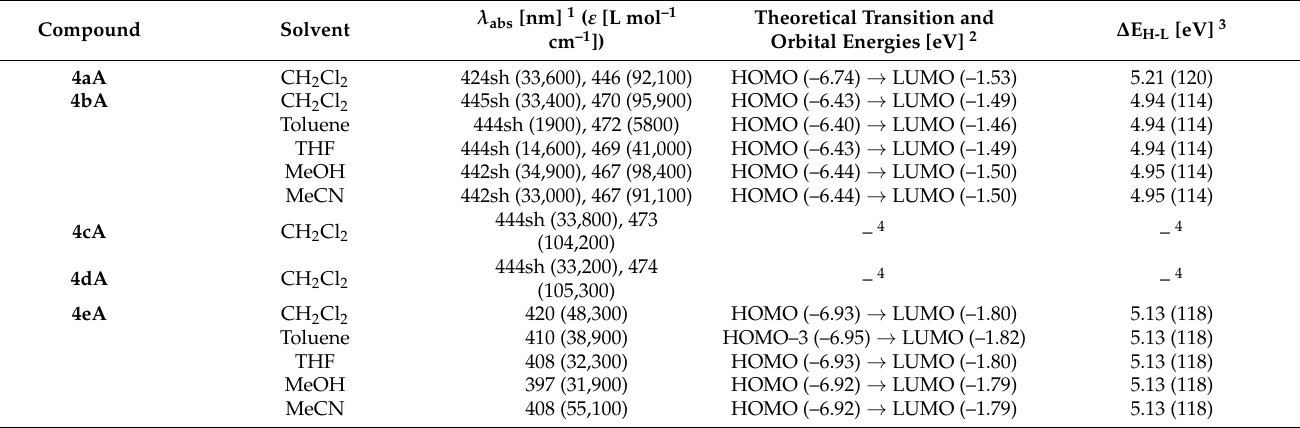
Figure 7. ( a ) UV-vis absorption spectra and photographs (inset) of 4aA – 4eA in CH 2 Cl 2 (concentration = 1.0 × 10 –5 mol · L –1 ); ( b ) the HOMO and LUMO distribution in 4aA as obtained from theoretical calculations. Table 4. Photophysical data of 4aA – 4eA 3e in numerous solvents and the corresponding calculated theoretical transitions.